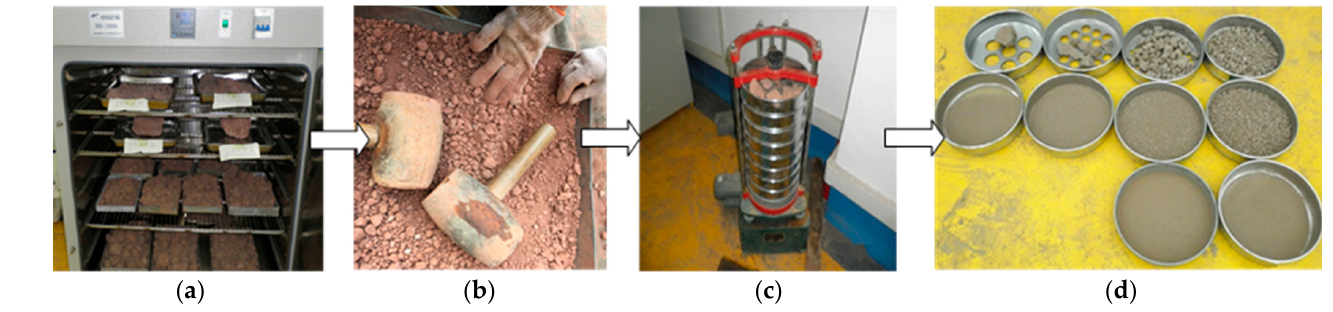
Figure 4. Particle grading test procedure. ( a ) Drying the samples; ( b ) hammering the fine-grained